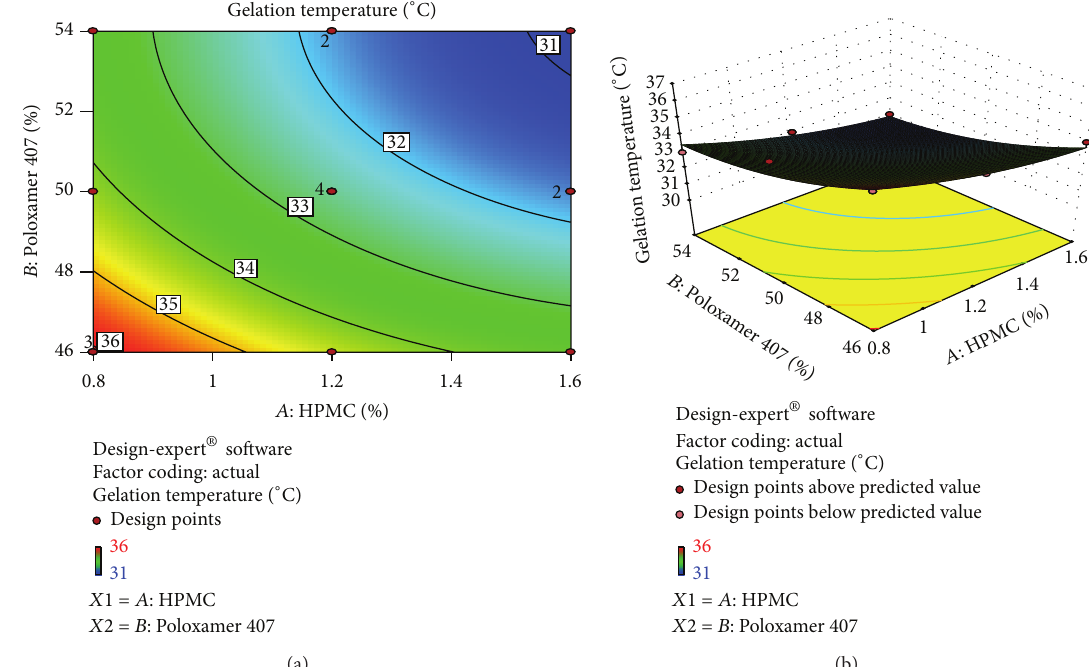
Figure 6: (a) Contour plot. (b) Response surface plot showed relationship in between % gelation temperature and polymer conc.